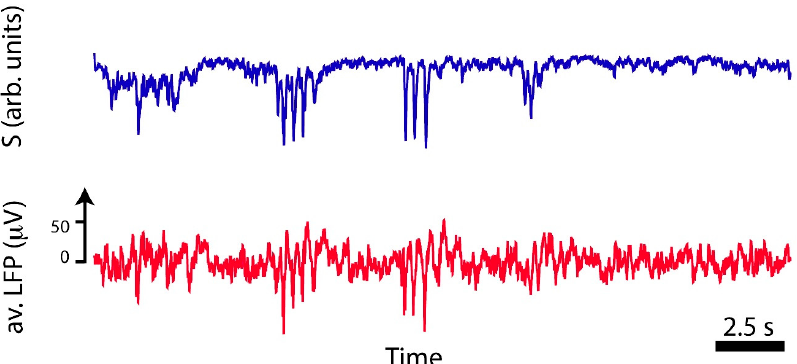
Figure 4. The reconstructed global synaptic activation captures prominent LFP features. Time traces for the global synaptic activation S (top panel, blue) and the trial- and channel- averaged LFP (bottom panel, red). The trace obtained for S approximates the measured LFP, especially where large peaks occur. The similarity between the two signals was measured using Pearson’s correlation coefficient, which yields a maximum value of c max ∼ 0.86 by taking the regions with the peaks and c mean ∼ 0.47 for the whole timespan. The difference in correlation strength means that the reconstructed S better approximates the LFP near signal events that correspond to the synchronous firing of multiple neurons (see Figure 3).